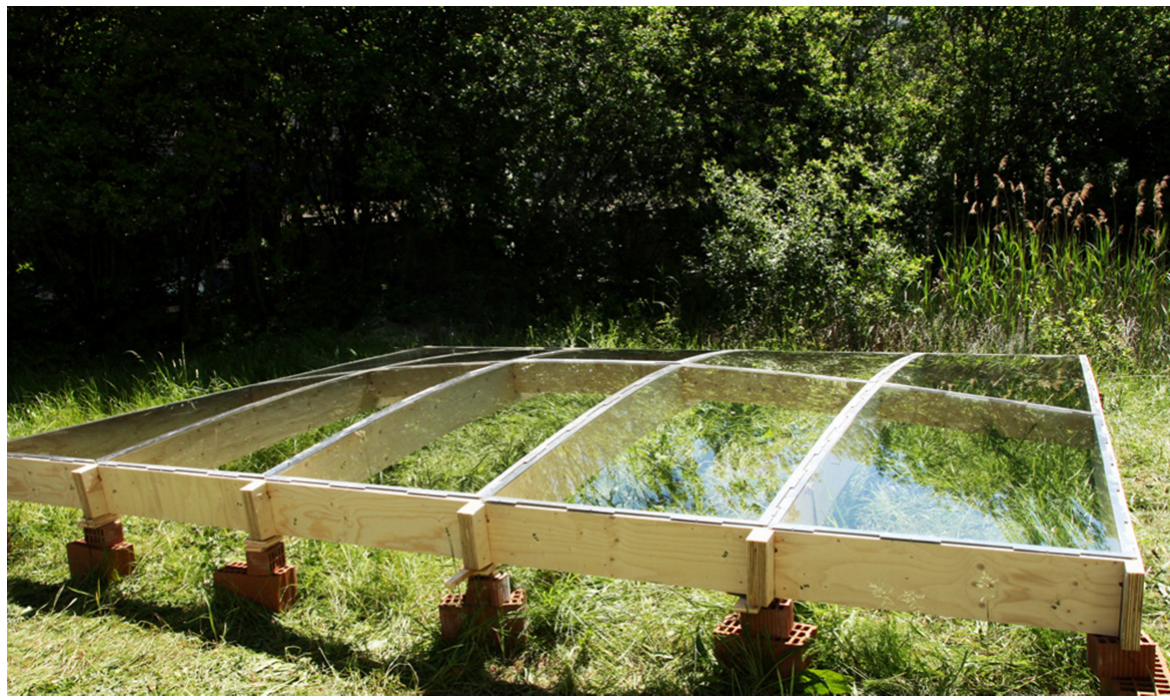
Fig. 16 Demonstrator